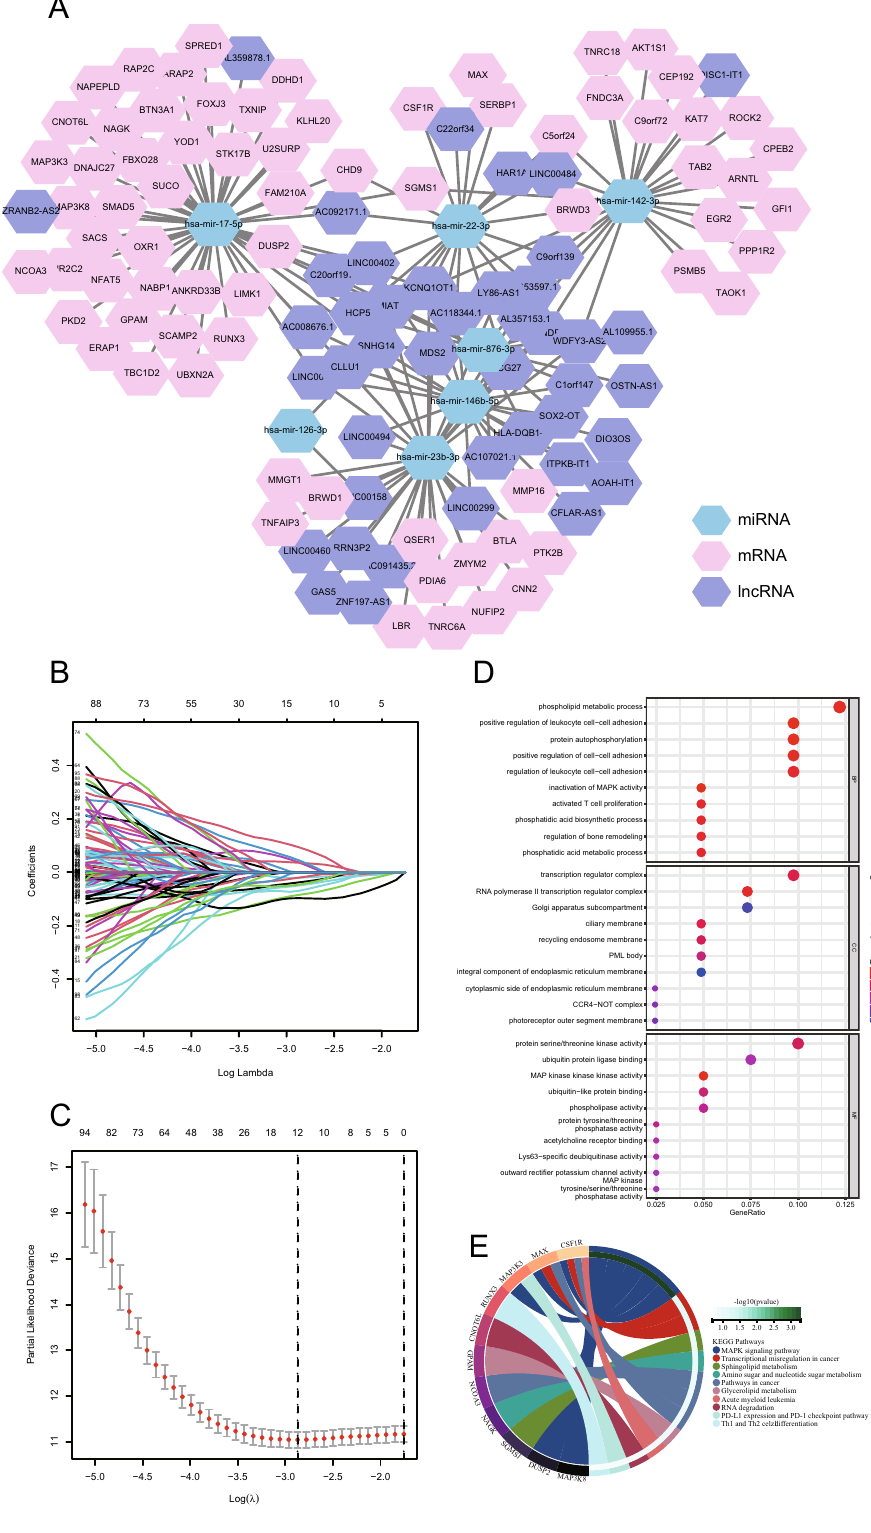
Figure 3. The immune molecules related to the prognosis of CM were screened. A ceRNA network of the differentially expressed lncRNAs, miRNAs and mRNAs in different immune groups ( A) . LASSO coefficient profiles of the genes in the ceRNA network ( B) . A coefficient profile plot was generated against the log (λ) sequence. Selection of the optimal parameter (λ) in the LASSO Cox regression analysis ( C) . Enrichment of top 10 GO terms (p ≤ 0.05) ( D) and KEGG pathways ( E) of the mRNAs associated with the seven selected immune molecules related to the prognosis of CM